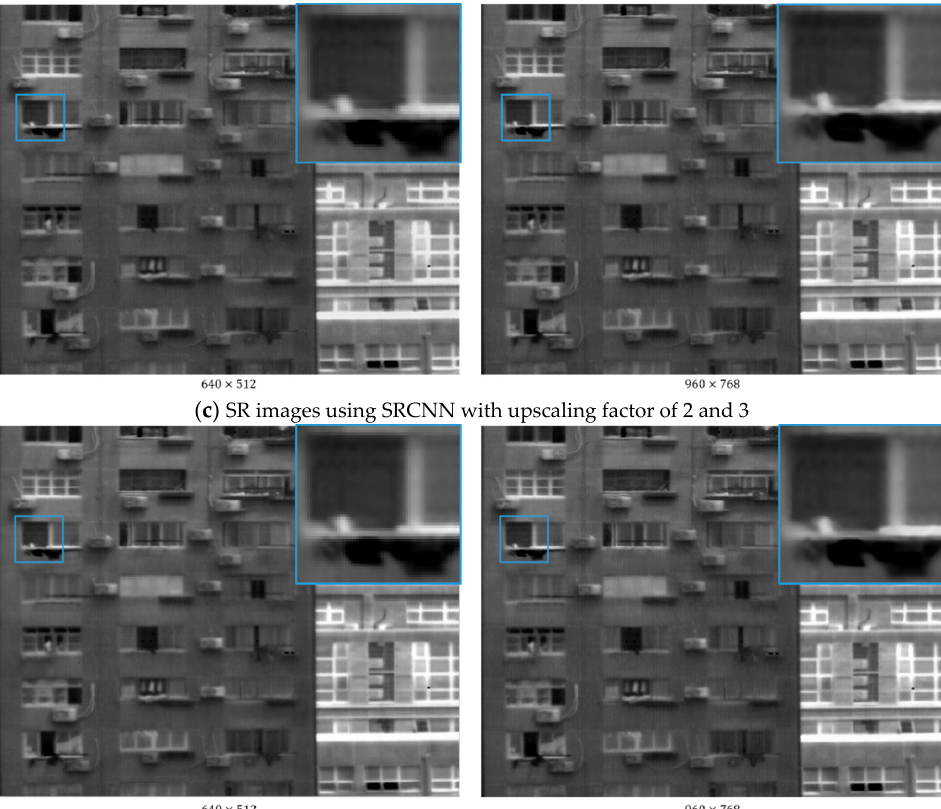
Figure 9. Imaging results comparison of the SR output.